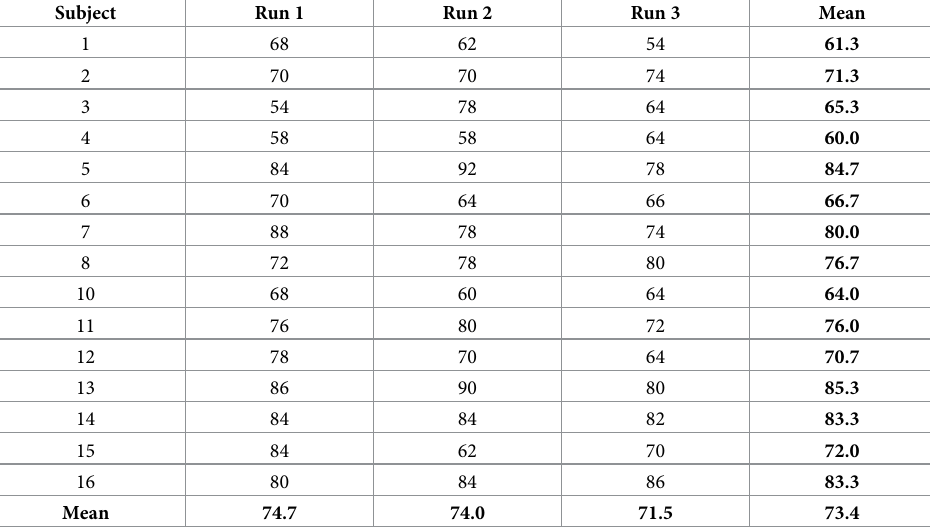
Table 2. Online classification accuracies (percent) when delivering proprioceptive feedback (Data 2).